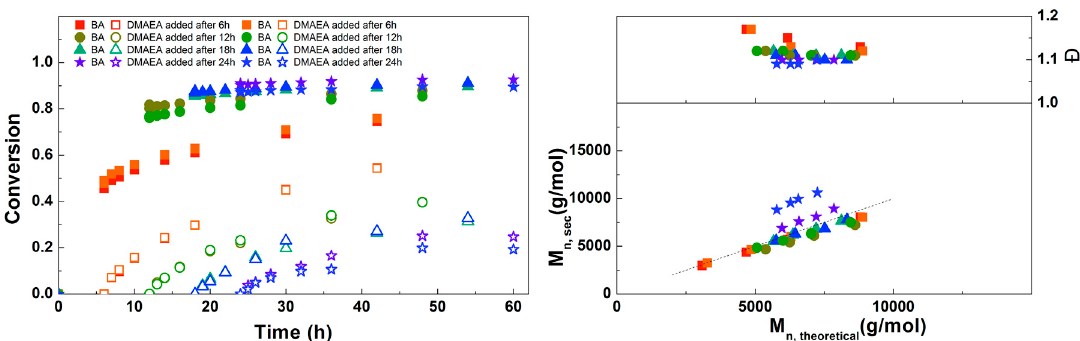
Figure 4. ( Left ): conversion versus time plot for Cu(0)-mediated one-pot block copolymerization of BA and DMAEA using [BA]:[DMAEA]:[ECP]:[Me 6 TREN]:[CuCl 2 ] = 50:50:1:0.15:0.1, 3.0 M in DMF at 25 °C and 12.5 mm 2 /mL Cu(0) wire. A 3.0 M solution of DMAEA in DMF was added after 6, 12, 18 or 24 h reaction time. ( Right ): corresponding molecular weight and dispersity versus theoretical molecular weight plot.